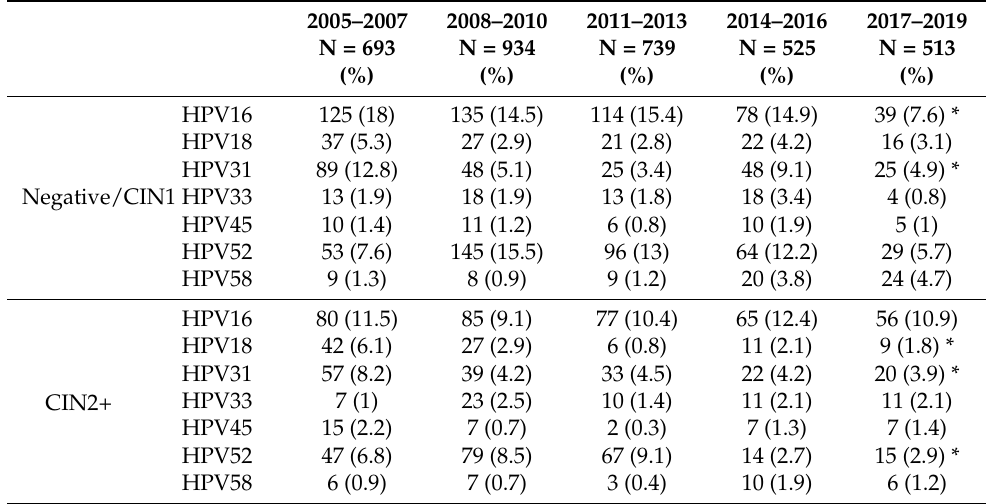
Table 4. Association between histological findings et enrolment and HR-HPV genotypes of Nova- valet vaccine in the five periods under